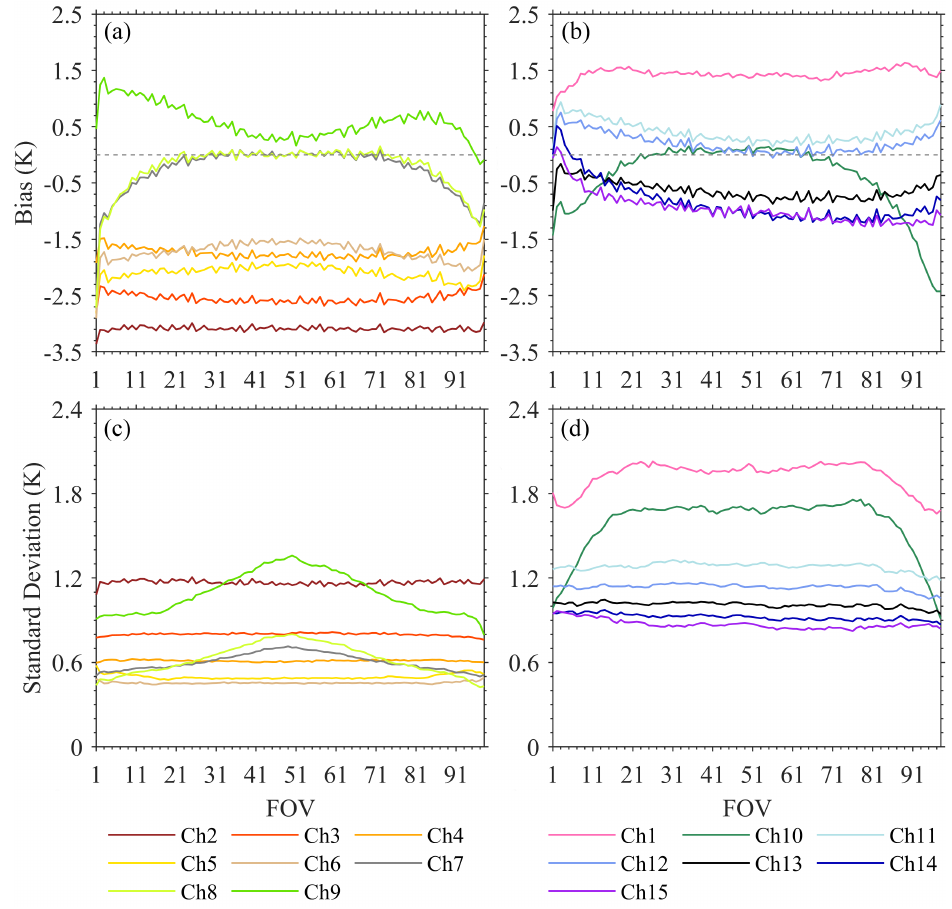
Figure 6. Variations of the biases (( a , b ), unit: K) and standard deviations (( c , d ), unit: K) with the 98 FOVs for the 15 channels. The left column indicates the results of the 118-GHz channels, and the right column indicates the other channels.